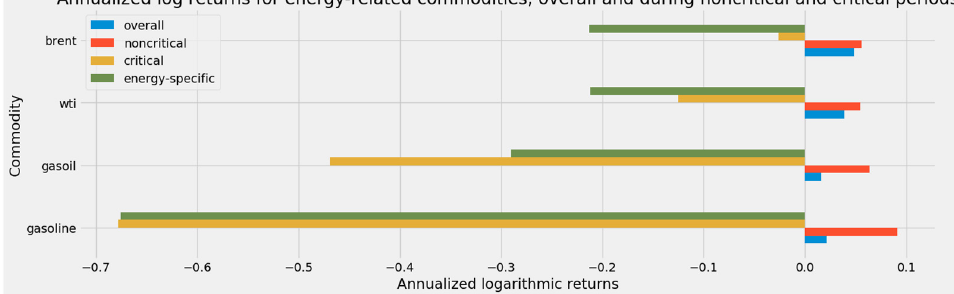
Figure 47. Annualized logarithmic returns on energy-related commodities, overall and during noncritical and critical periods.